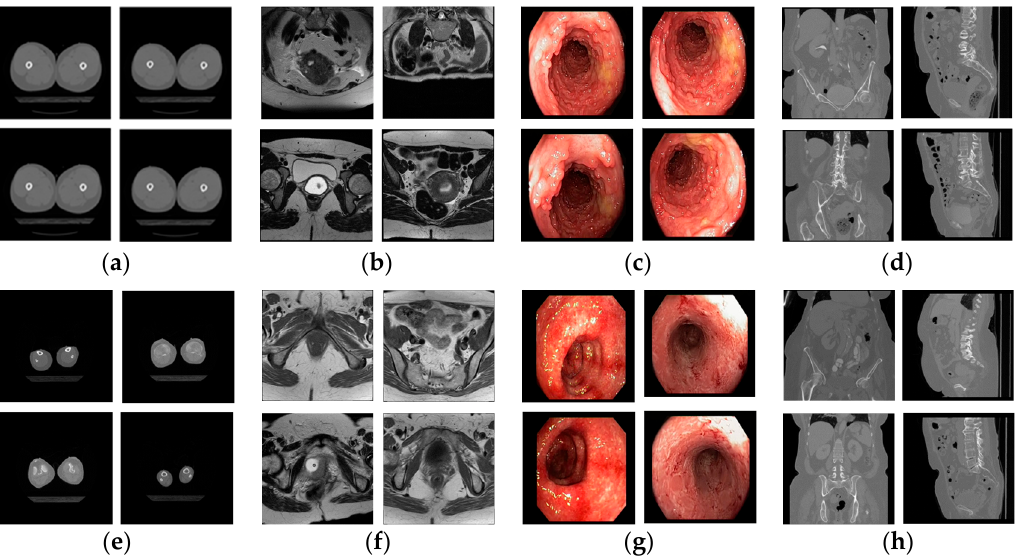
Figure 8. Selected example images for showing high inter-class similarity; ( a , e ) hip CT in Figure 5a-1 and knee CT in Figure 5a-2, respectively; ( b , f ) cervix MRI in Figure 5a-4 and bladder MRI in Figure 5a-9, respectively; ( c , g ) benign tumors in Figure 5d-7 and Rectum in Figure 5d-1, respectively; ( d , h ) urography CT in Figure 5b-2 and uterus CT in Figure 5b-5,